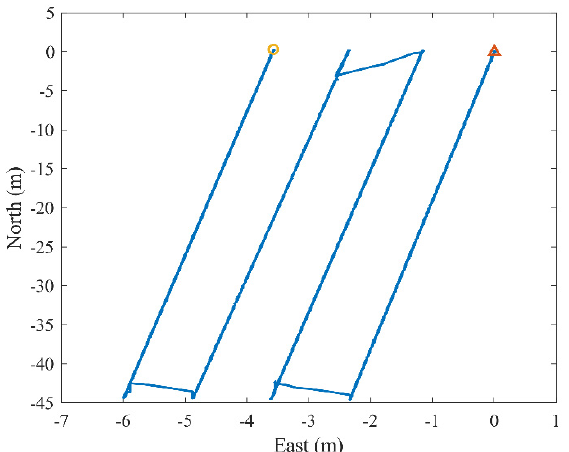
Figure 14. Trajectory of the mobile carrier during the experiment.